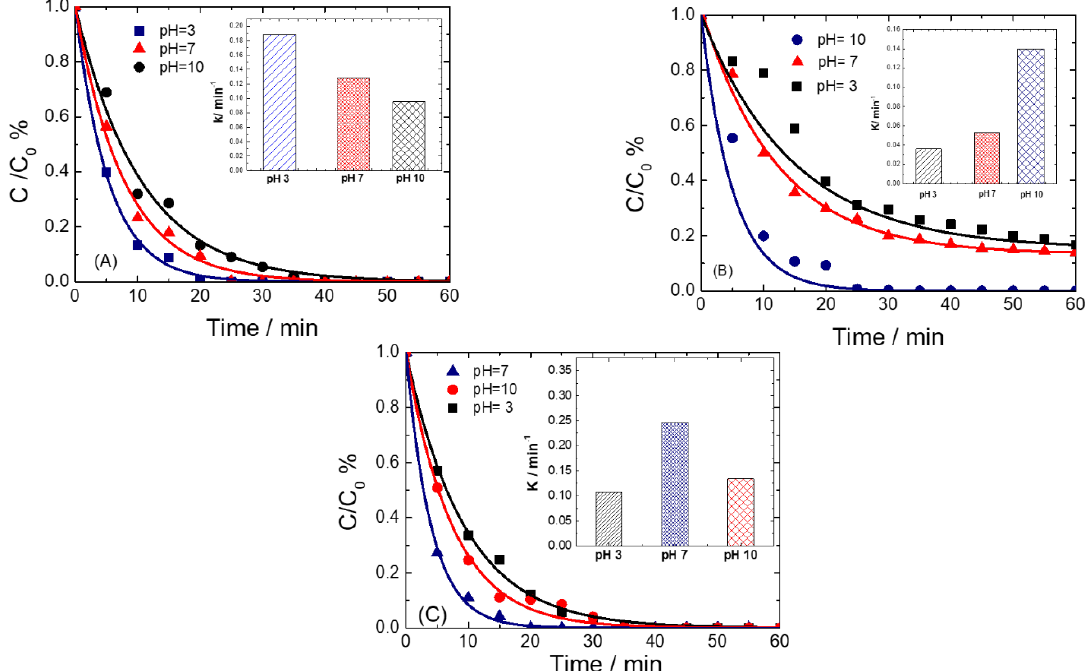
Figure 8. Imazapyr degradation as a function of time for different pH by photocatalysis ( A ), ozonation ( B ), photocatalytic ozonation ( C ) C (Imazapyr) = 5 μΜ); stirring speed = 1000 min −1 , m TiO 2 = 50 mg). aqueous suspension Milli-Q water.